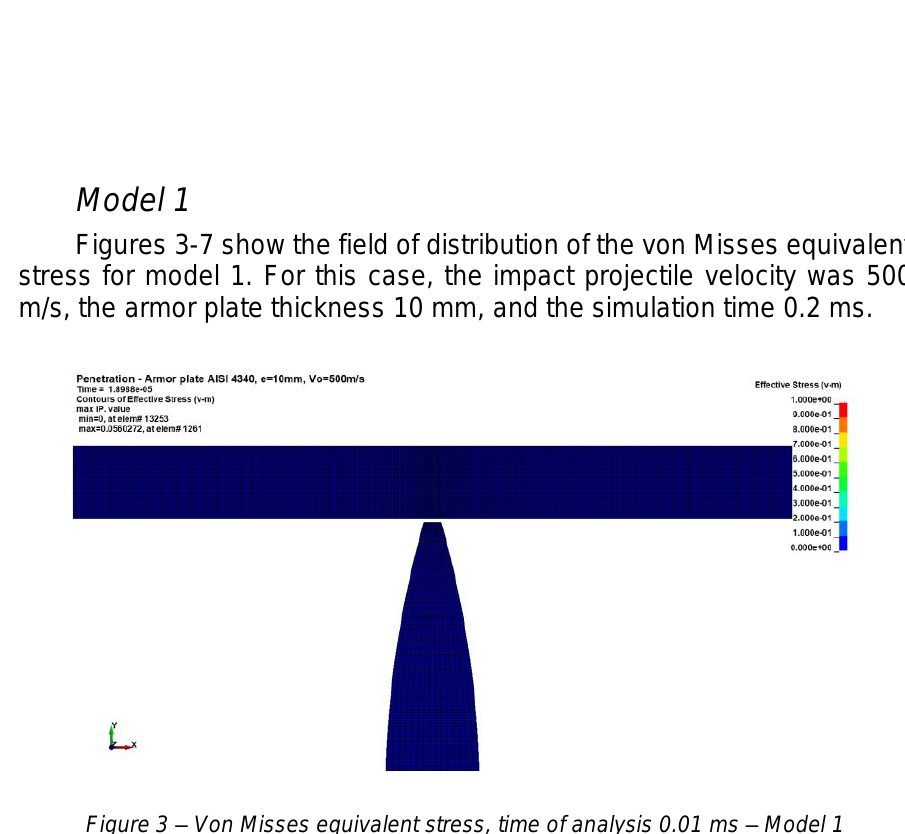
Figure 3 – Von Misses equivalent stress, time of analysis 0.01 ms – Model 1 Рис. 3 – Von Misses эквивалентное напряжение, время анализа 0.01 ms – Модель 1 1